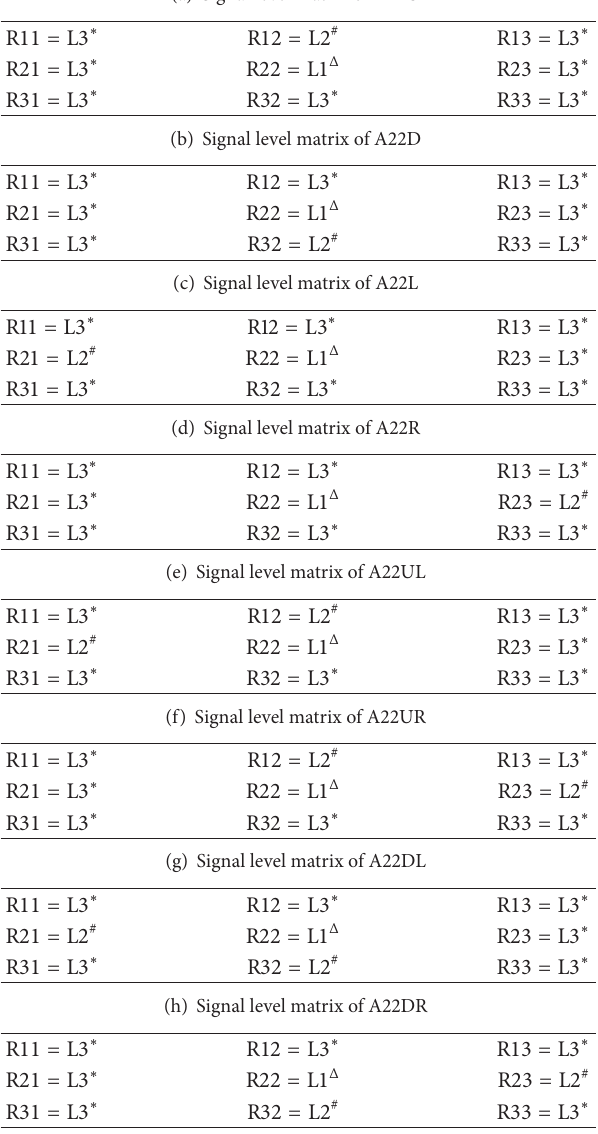
Table 3: The signal level matrix of a tag located in the areas of A22U, A22D, A22L, A22R, A22UL, A22UR, A22DL, and